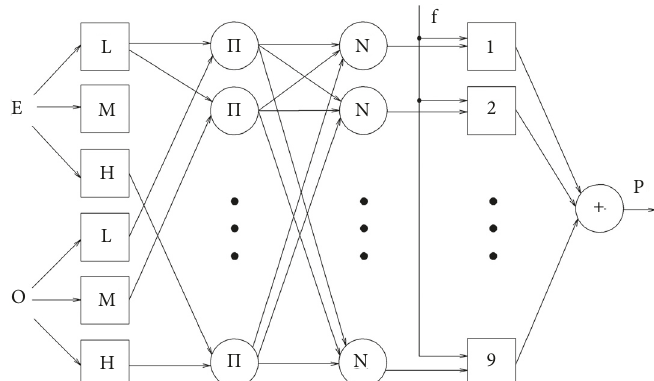
Figure 6: Block diagram of the neurofuzzy controller. Each neuron in first layer is used to fuzzify received crisp inputs. Nine neurons in second layer correspond to a fuzzy rule. Neurons in the third layer are used for the normalization of the values. The fourth layer is the defuzzification one. The single neuron in fifth layer represents an output of the neurofuzzy system.